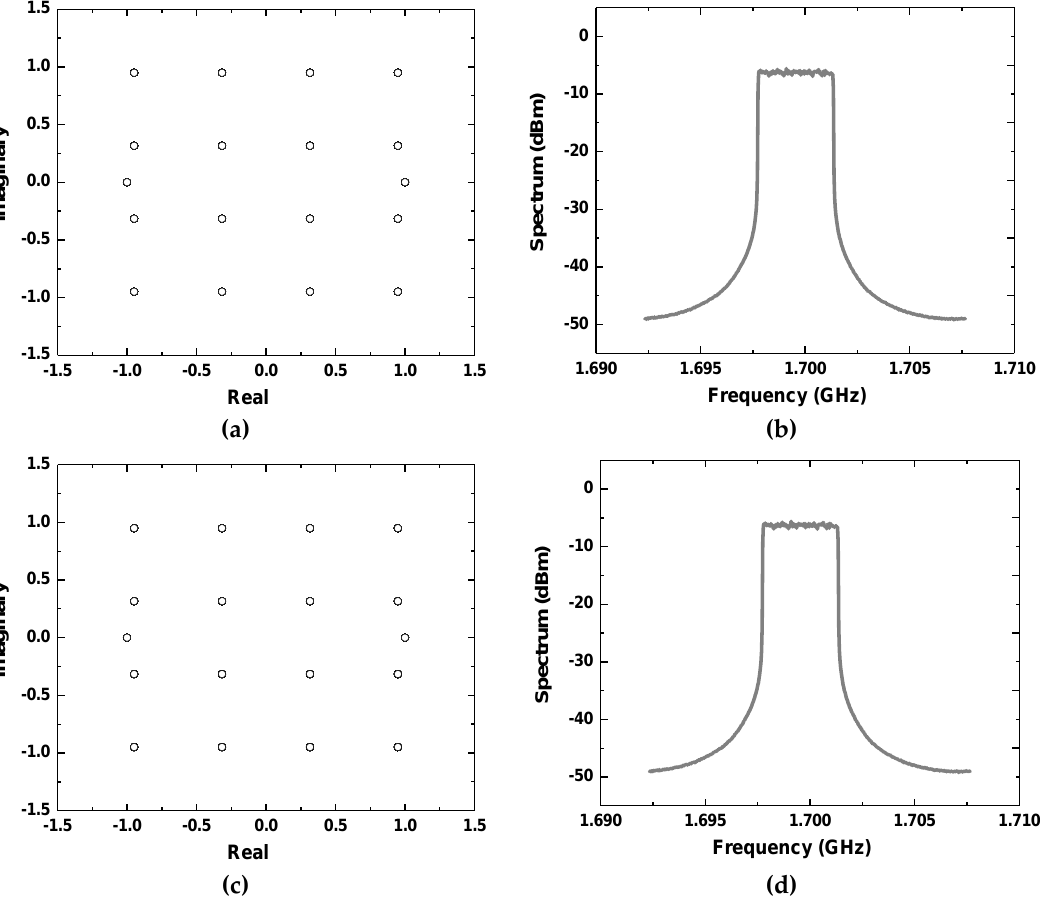
Figure 5. Simulated results of the outphasing combiners: ( a ) output constellation of the SCT; ( b ) output spectrum of the SCT; ( c ) output constellation of the PCT; ( d ) output spectrum of the PCT.